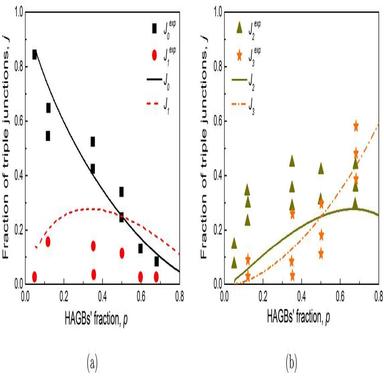
Comparison of experimental values (symbols) for (a) J0 exp, J1 exp and (b) J2 exp, J3 exp with the corresponding curves J0, J1, J2 and J3 obtained with MEPP-controlled conversion of LAGBs to HAGBs.